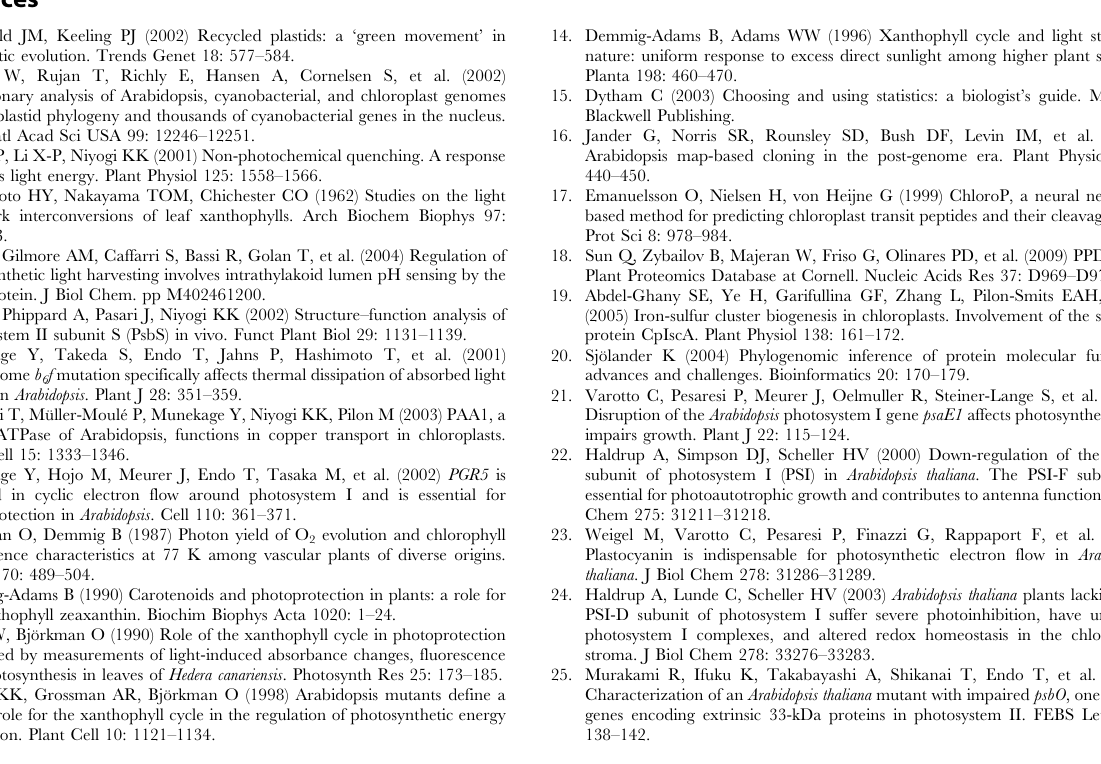
Figure S1 Maximum likelihood phylogenetic tree of PGR7 homologs. Found at: doi:10.1371/journal.pone.0011688.s001 (1.04 MB TIF) Figure S2 Results of complementation test between pgr7 and npq4 . The maximum fluorescence image after dark-adaptation (Fm) was captured after 30 min dark-adaptation; and then the maximum fluorescence image in the light-adapted condition (Fm’) was captured after 2 min actinic illumination (500 m mol photons m-2 s-1). Found at: doi:10.1371/journal.pone.0011688.s002 (0.84 MB